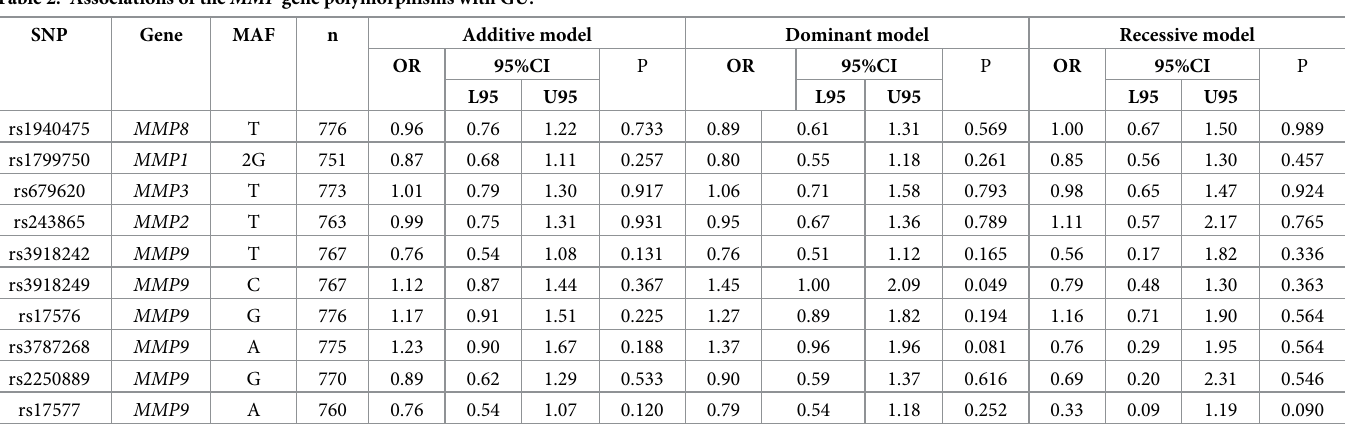
Table 2. Associations of the MMP gene polymorphisms with